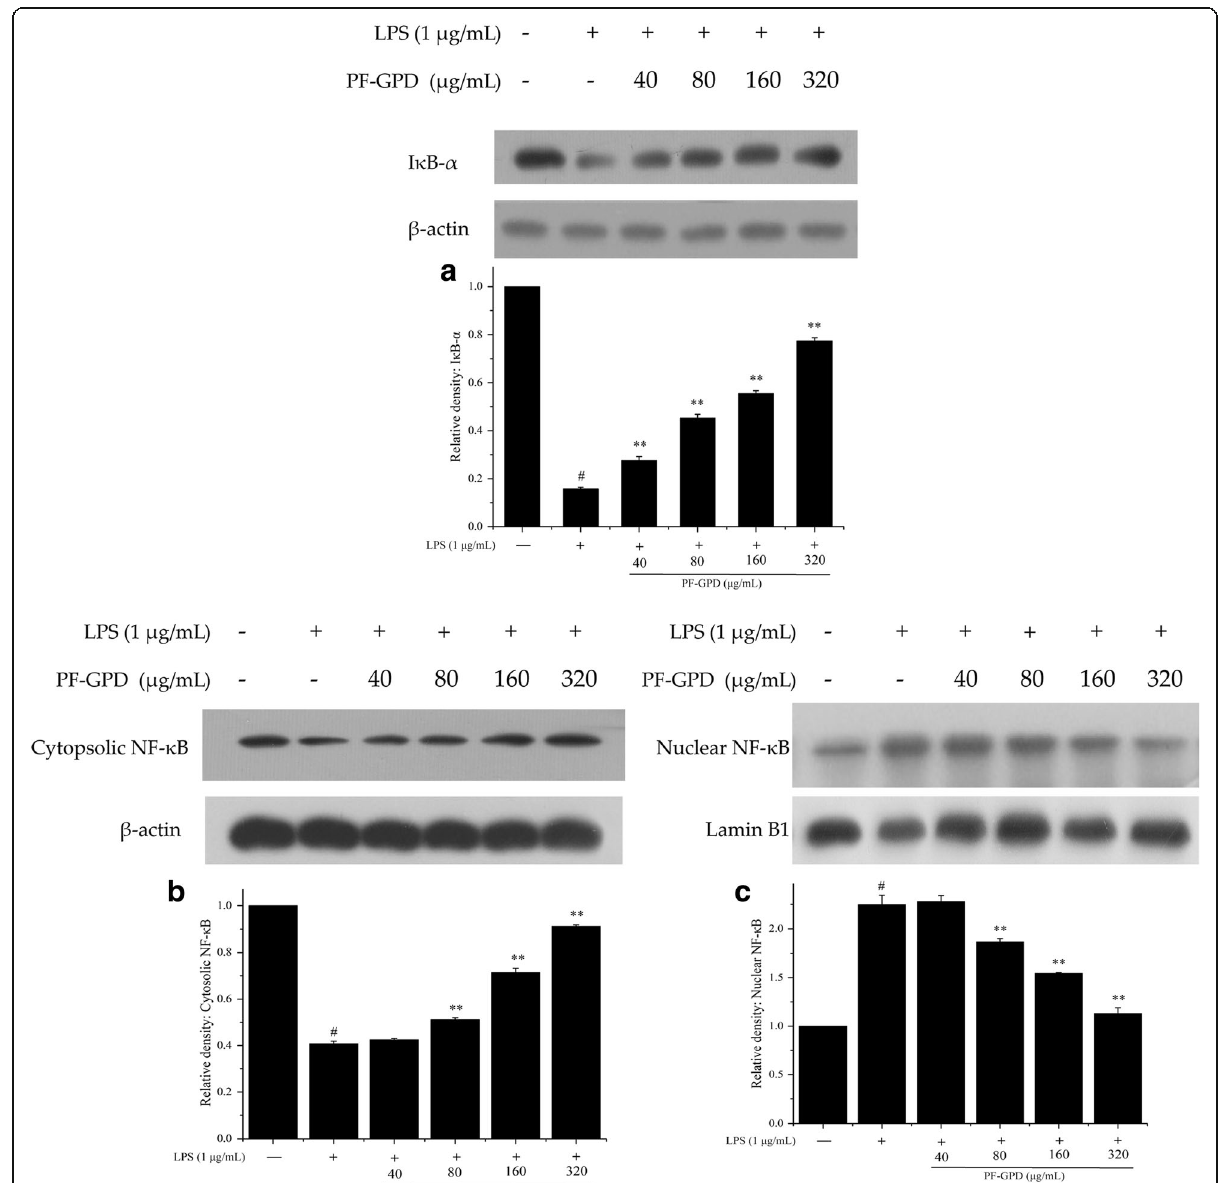
Fig. 7 The composition of PF-GPD was analyzed by SHIMADZU API 4000 LC/MS/MS system equiped with SHIMADZU VP-ODS column (4. 6 mm × 150 mm). The mobile phase A was 1% formic acid, mobile phase B was acetonitrile, the gradient elute condition was 0 – 5 min 45% mobile phase B, flow velocity is 0.5 mL/min, and the column temperature was 40 °C. The total ion chromatography of PF-GPD and extract ion chromatography of the L-leucine, L-lysine and L-valine were shown in picture a , b , c and d,